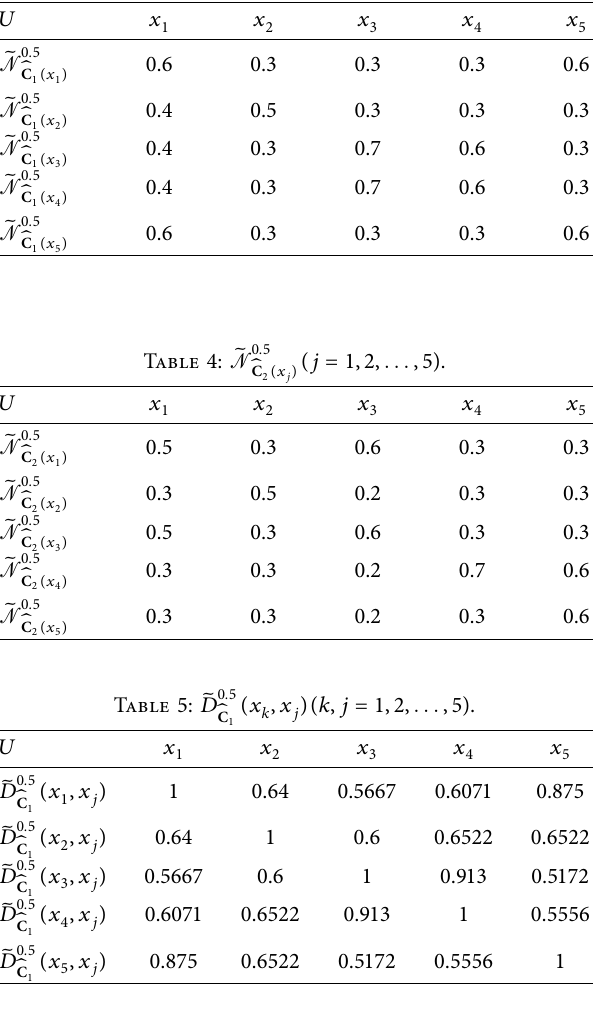
( j � 1 , 2 , ... , 5 ) C 1 ( x j )